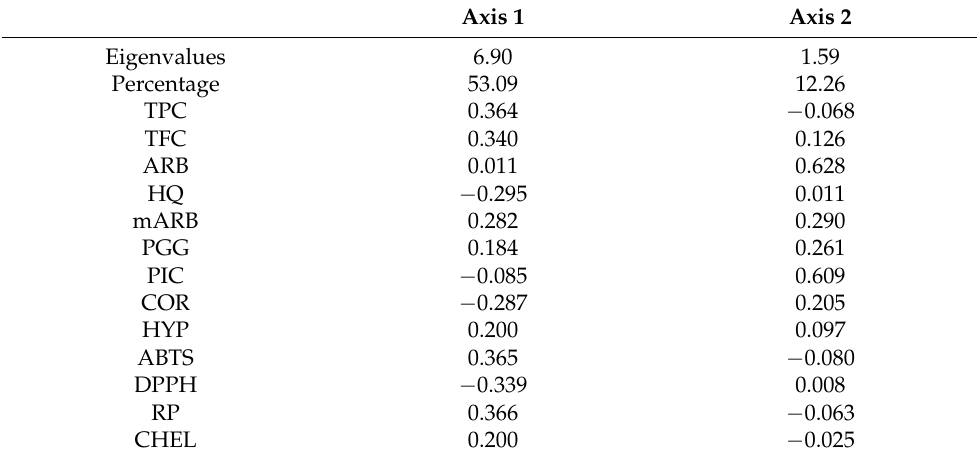
Table 3. Results of PCA based on the secondary metabolite composition of bearberry water and ethanol leaf extracts and antioxidant properties. TPC—total phenolic concentration, TFC—total flavonoid concentration, ARB—arbutin, HQ—hydroquinone, mARB—methylarbutin, PGG—penta- O-galloyl- β -d-glucose, PIC—picein, COR—corilagin, HYP—hyperoside, ABTS—ABTS •+ scaveng-